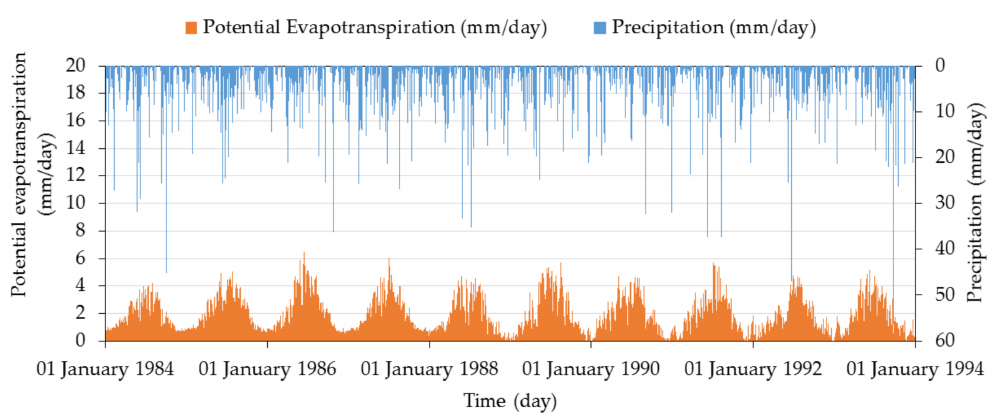
Figure 3. The daily precipitation and potential reference evapotranspiration data for the study area from 1984 to